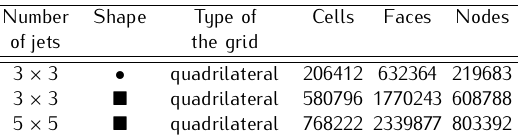
Table 2. Computational grid – details.